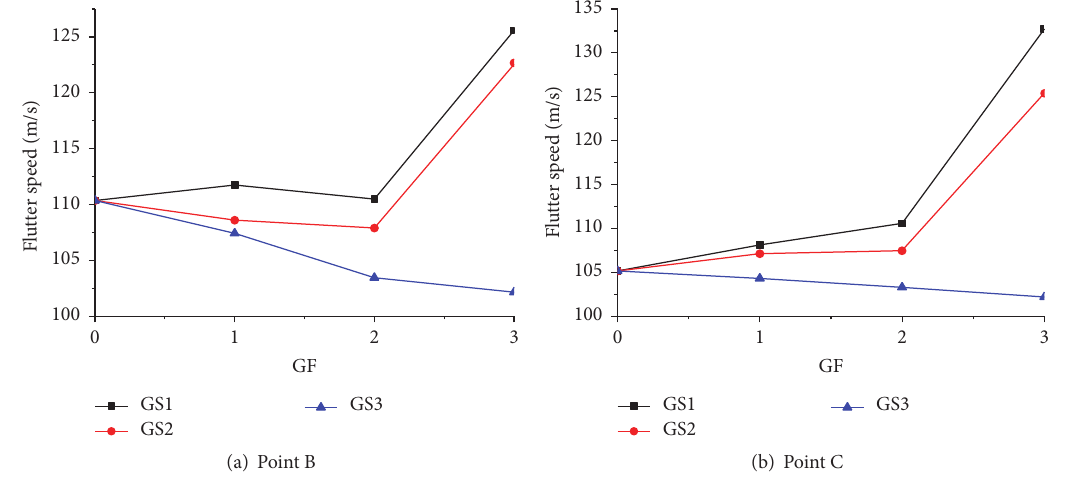
Figure 8: Flutter speed of the two sets with various GS and